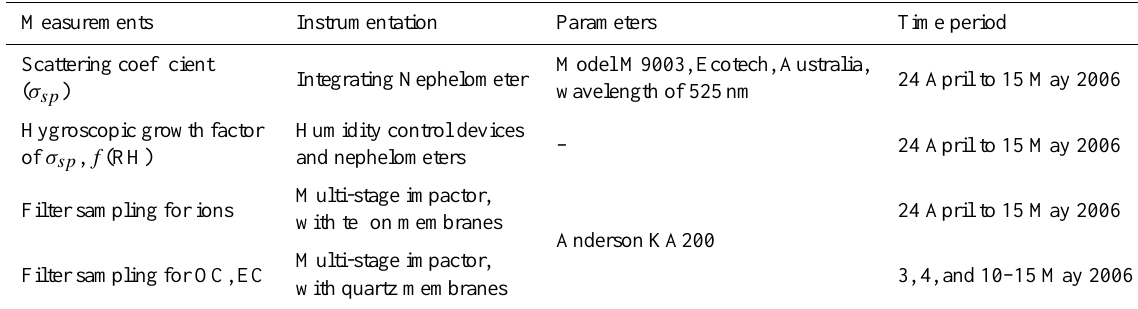
Table 1. Instrumentation of